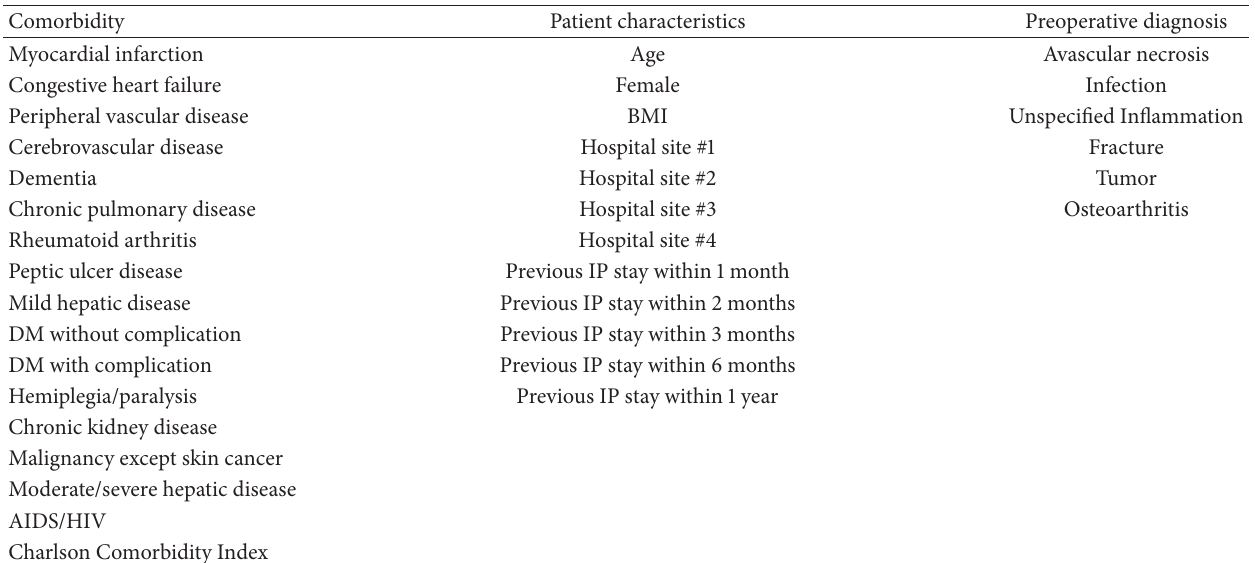
Table 5: Initial variables for multivariable S. aureus colonization prediction